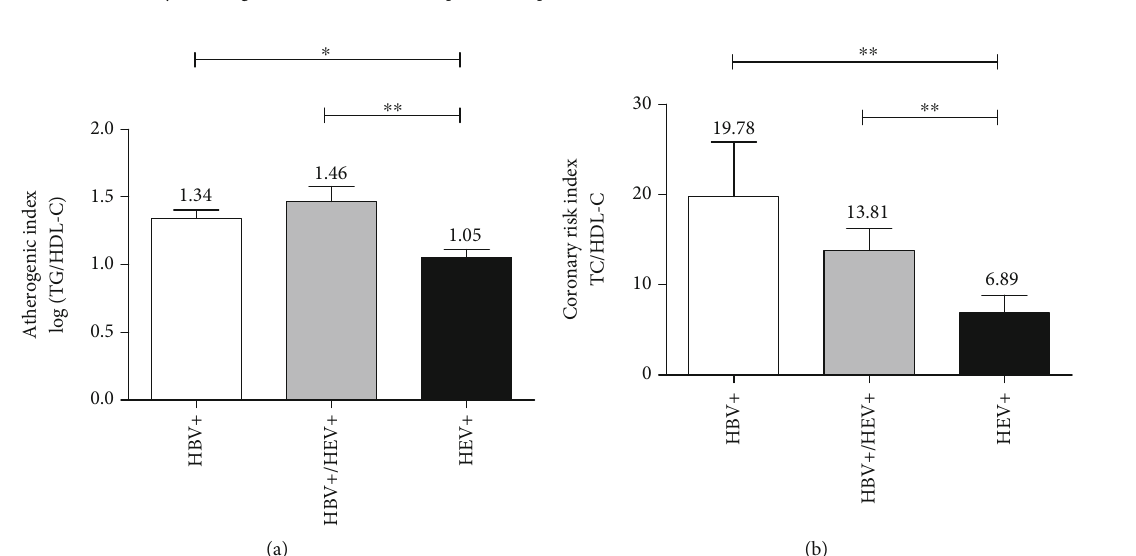
Figure 3: Mean coronary and atherogenic risk indexes of HBV/HEV-coinfected and monoinfected groups. The comparison was performed using the nonparametric Kruskal-Wallis test followed by Dunn ’ s multiple comparison post hoc test. ∗ p < 0 : 05 , ∗∗ p < 0 : 01